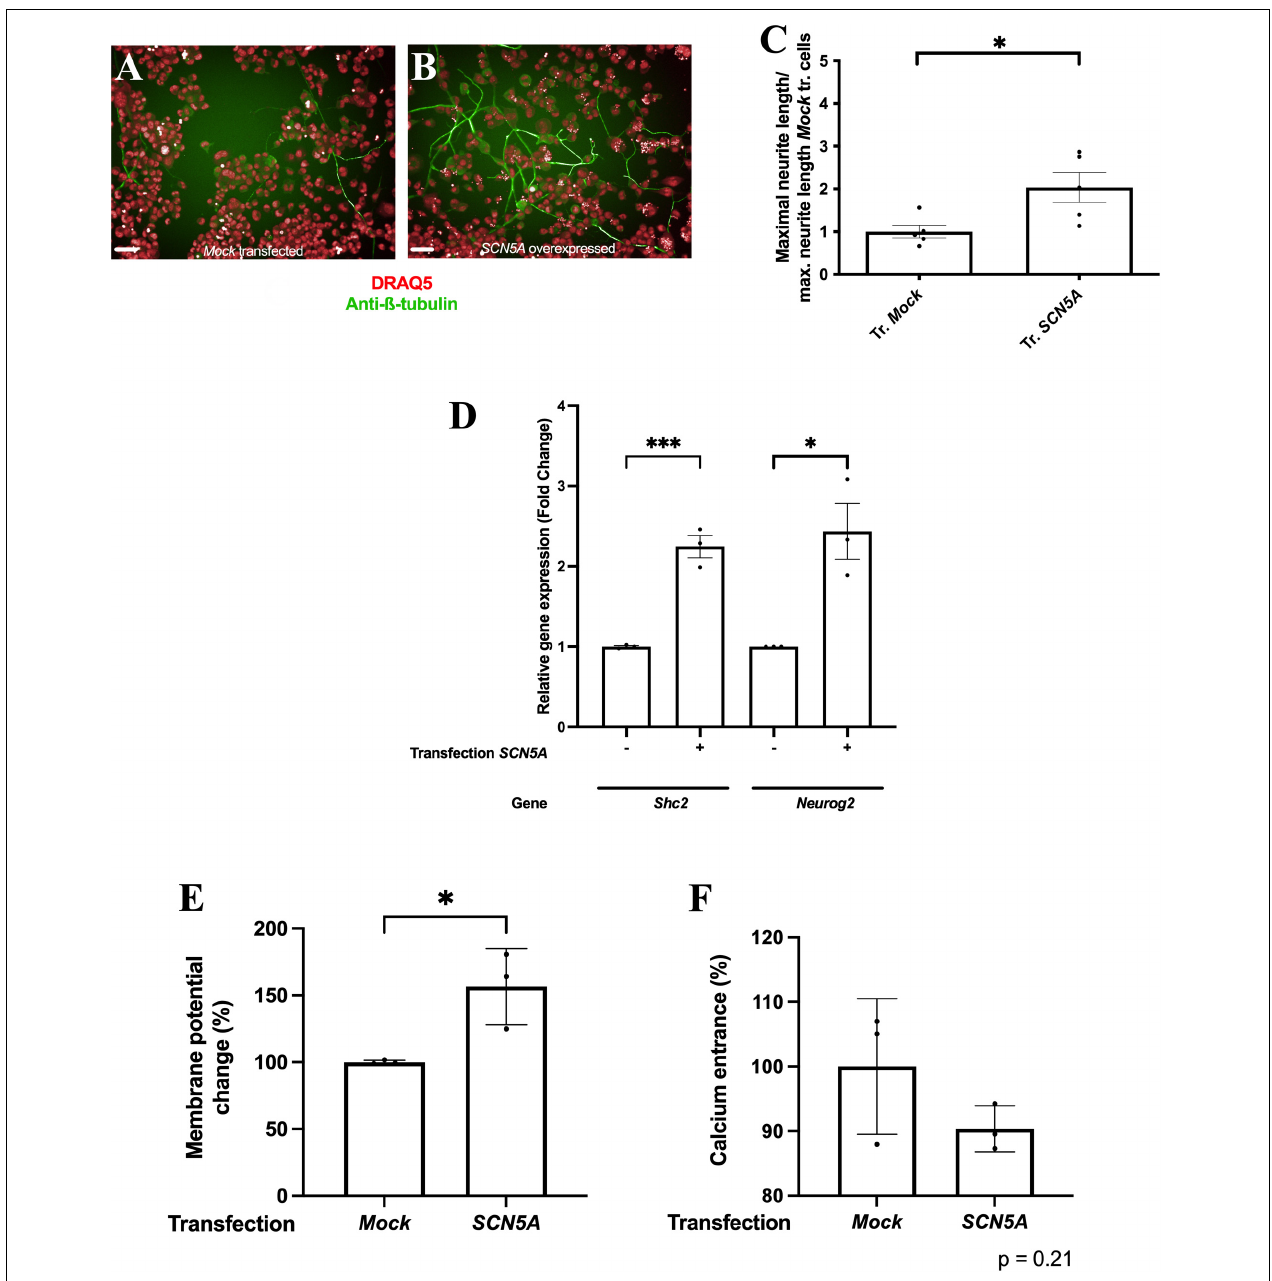
FIGURE 3 | Overexpression of the gene encoding the Na V 1.5 channel induces the acquisition of phenotypic features of DRG neurons. Representative images of (A) F11 cells transfected with an empty plasmid and (B) F11 cells transfected with the SCN5A gene. Images are representative of five independent assays ( n = 5) with six replicates per condition, 20X. Scale bar = 50 µ m. (C) Mean neurite length of F11 cells transfected with SCN5A and with an empty plasmid. Values shown for (C) are the means ± SEM of five independent assays ( n = 5) with six replicates per measurement. ∗ p < 0.05 (Student’s t -test). (D) Comparative quantification of Shc2 and Neurog2 gene expression by RT–qPCR in F11 cells transfected with an empty plasmid and with an SCN5A gene-containing plasmid. Values shown are the means ± SD of three independent assays ( n = 3) with three replicates per measurement. ∗∗∗ p < 0.001; ∗ p < 0.05 (Student’s t -test). (E) Membrane potential change measured with FluoVolt elicited by 30 mM KCl in F11 cells transfected with an empty plasmid and with an SCN5A gene-containing plasmid. Values shown are the means ± SD of three independent assays ( n = 3) with four replicates per measurement. ∗ p < 0.05 (Student’s t- test). (F) Intracellular calcium concentration increase elicited by 30 mM KCl in F11 cells transfected with an empty plasmid and with an SCN5A gene-containing plasmid. Values shown are the means ± SD of three independent assays ( n = 3) with four replicates per measurement.